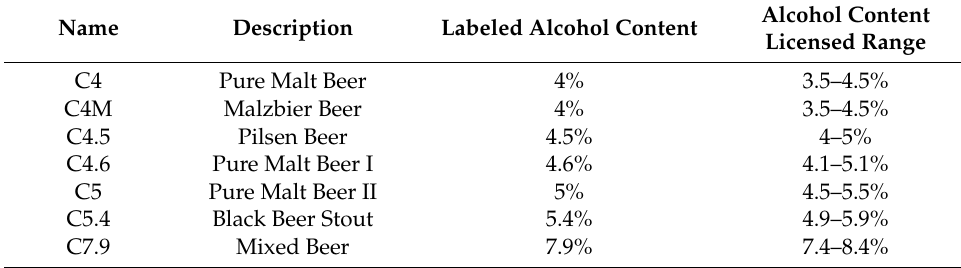
Table 2. Commercial beverages used to test the